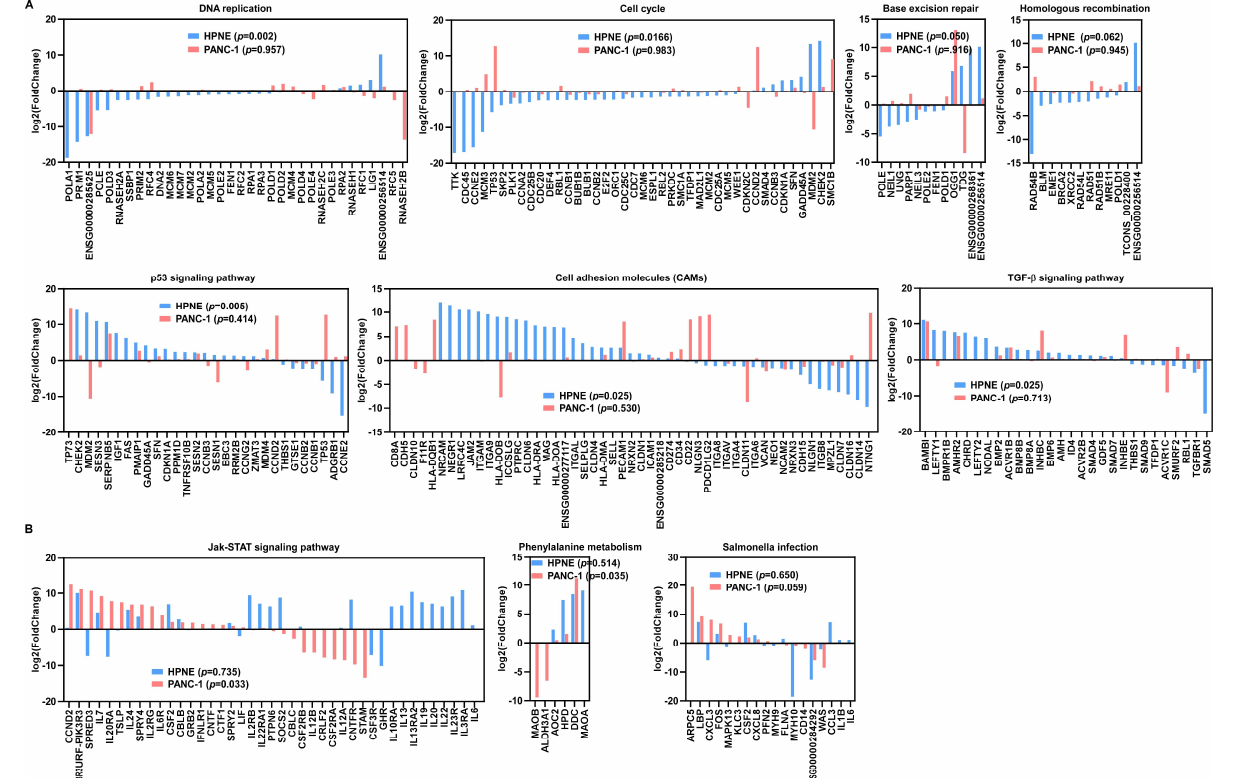
Figure 3. Distribution of differentially expressed genes in the H 2 O 2 -induced pathways identified by KEGG pathway enrichment analysis. ( A ) Expression of enriched genes in the indicated pathways associated with DNA replication, cell cycle, homologous recombination, base excision repair, p53 signaling, cell adhesion molecules (CAMs), and TGF-β signaling in HPNE cells. ( B ) Expression of enriched genes in Jak/STAT signaling pathway, phenylalanine metabolism, and salmonella infection, which changed significantly in PANC-1 cells.